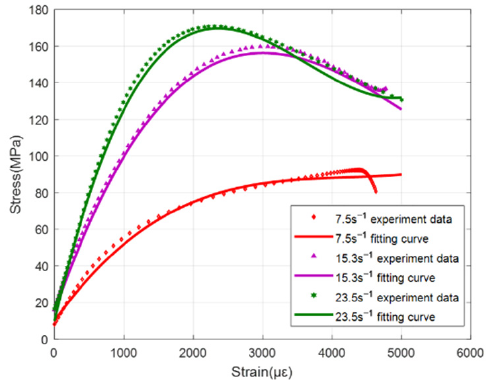
Figure 14. Comparison of fitting results with test results.